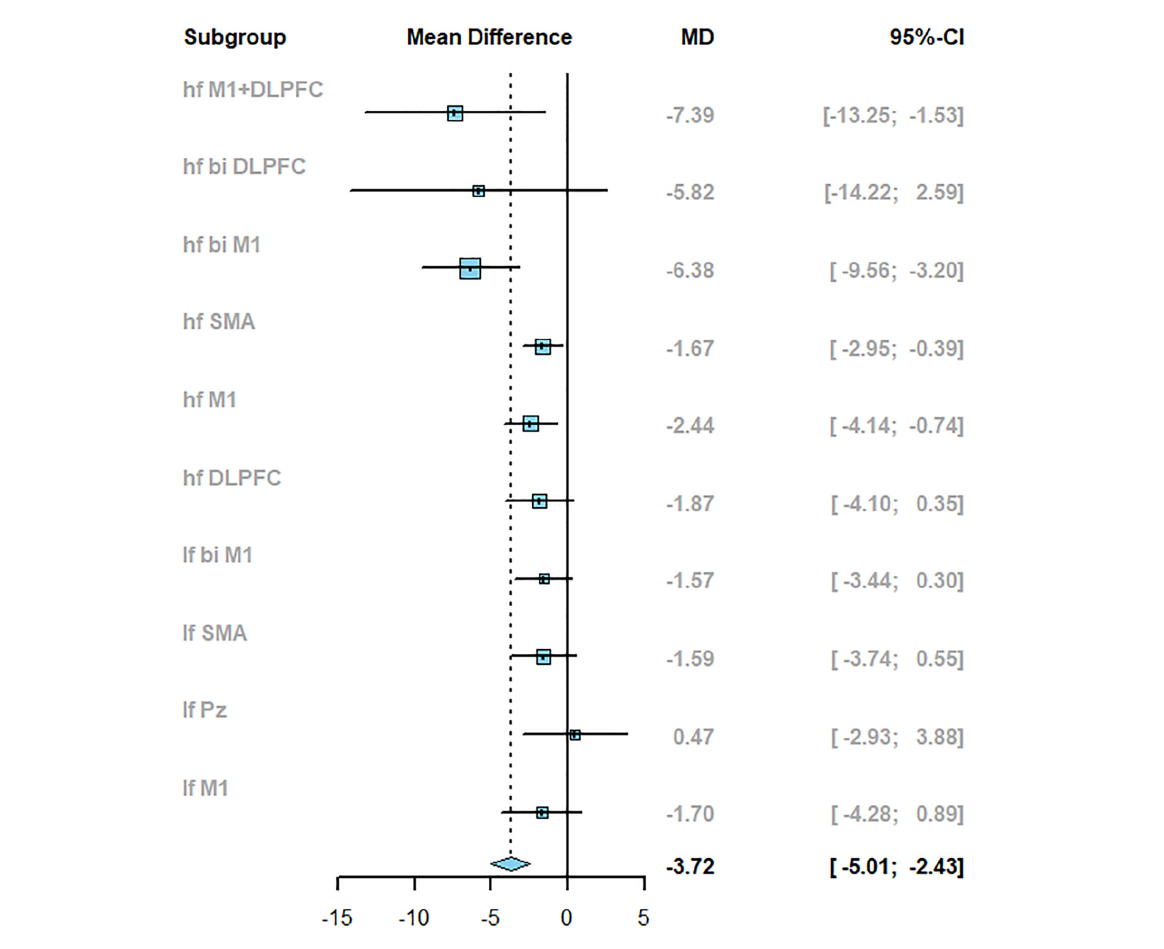
compared with sham condition. All low-frequency parameters were not effective in improving motor symptoms in PD